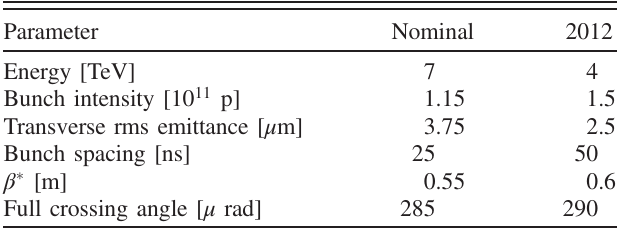
TABLE I. Beam and machine parameters in 2012 compared to